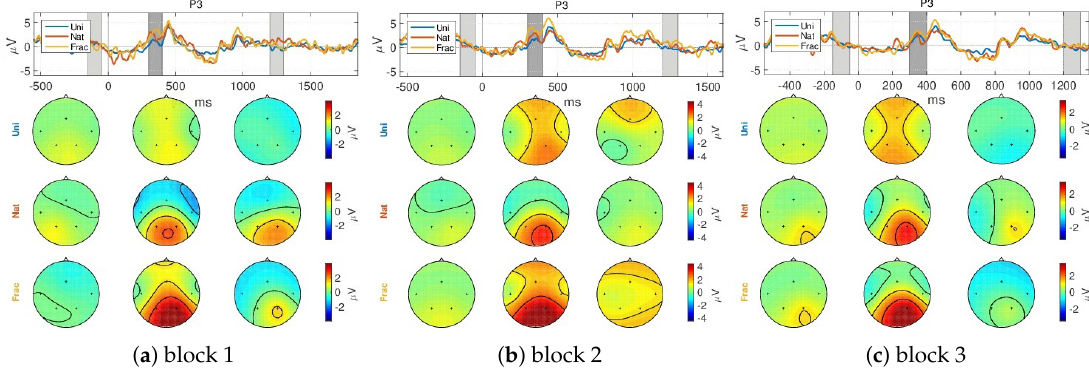
Figure A10. GA ERP over blocks for channel P3. The GA ERPs for all 5 recorded neural channels: Fz, T3, T4, P3, P4 is shown in